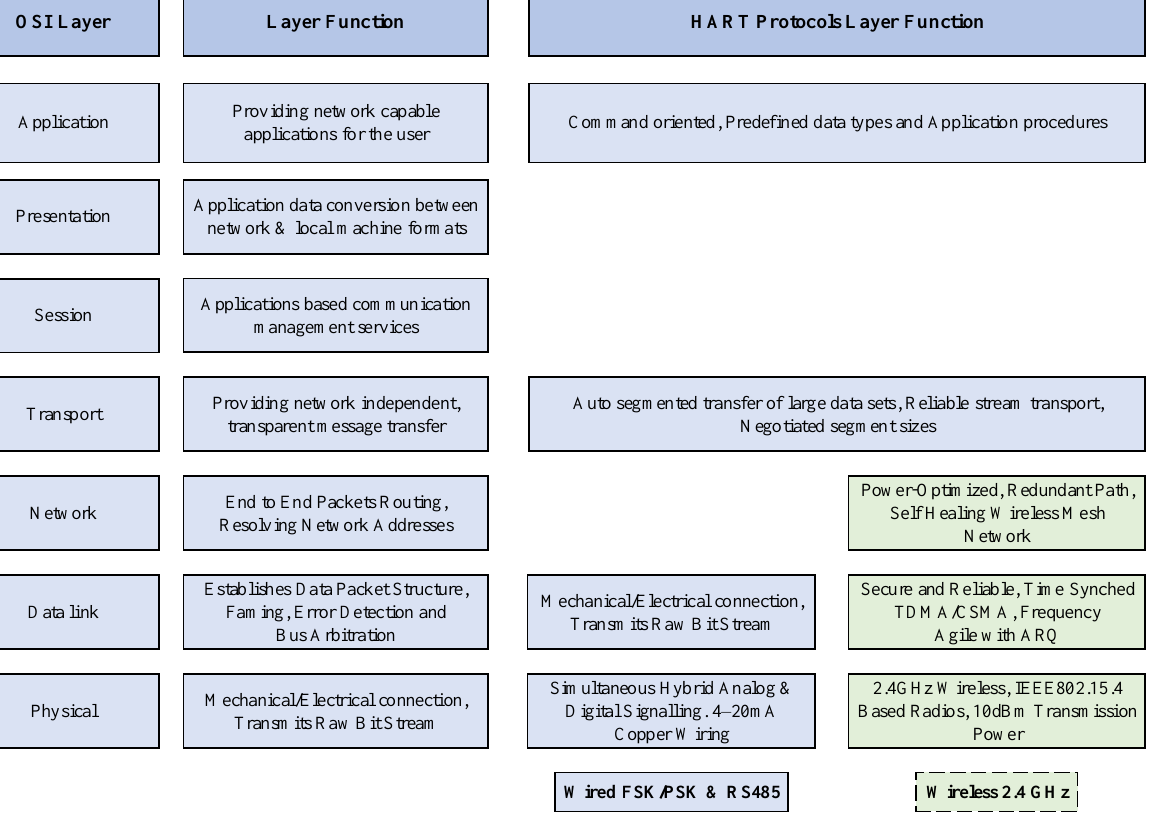
Figure 6. OSI layer of the conventional wired HART and the WirelessHART protocols